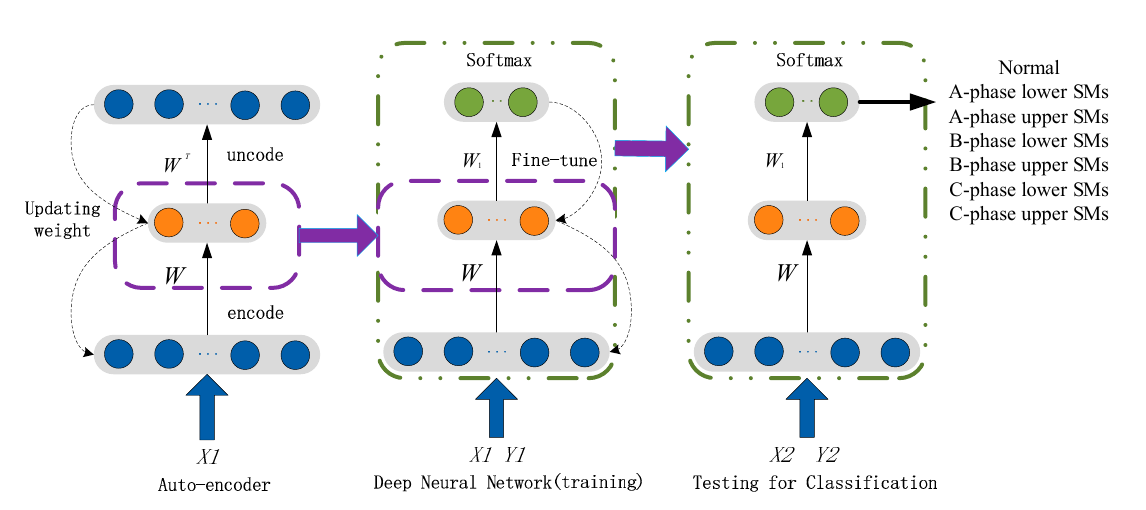
Figure 5. Architecture of the autoencoder (AE)-based deep neural network (DNN).